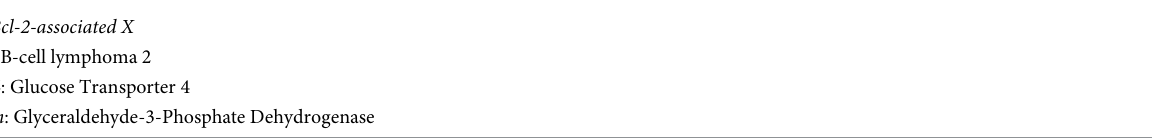
of treatment with plant extracts according to the product manufacturer’s protocol. The RNA was dissolved in DEPC water and stored at -80˚C until it was used. The concentration of RNA samples of the total RNA with 260/280 nm ratio: 1.8–2.1 were used for complementary DNA (cDNA) syn-